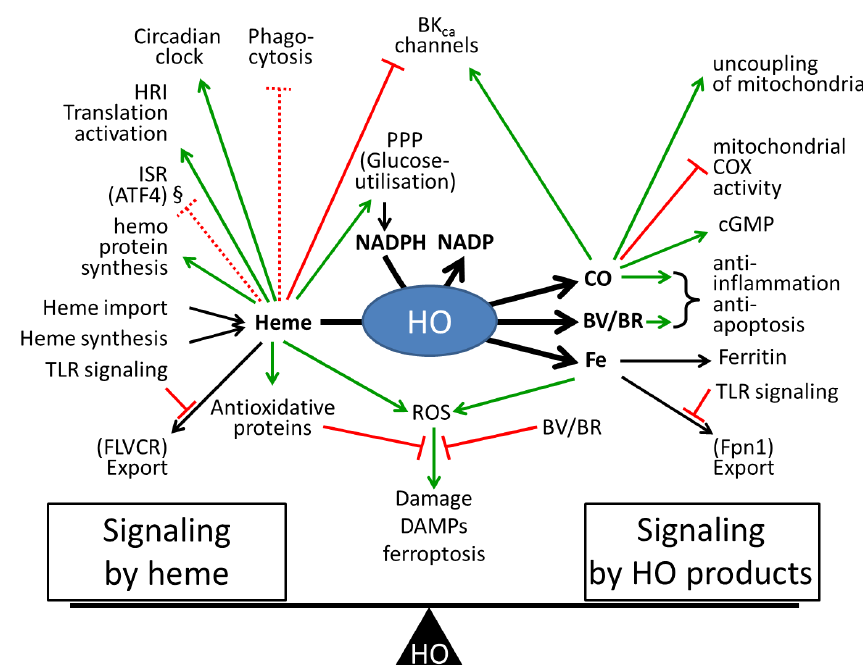
Figure 2. Role of HO as master regulator of cell physiology. Highly active HO shifts the balance from heme mediated signaling towards HO product mediated signaling. Low activity results in an increased heme mediated signaling. Black arrows indicate direct processes associated with HO activity. Green arrows indicate elicited e ff ects; red blocks indicate inhibitory actions of the indicated compounds. Interactions occurring in specialized cells, such as erythroid cells, or macrophages, are indicated by dotted lines. §, integrated stress response (ISR) pathway is activated via ATF4 by heme deficiency, indicating that physiological heme levels repress ATF4 activation. Abbreviations: ATF4, Activating transcription factor 4; BK Ca , conductance Ca 2 + -activated K + channels; BV / BR, biliverdin / bilirubin; cGMP, cyclic guanosine monophosphate, CO, carbon monoxide; COX, cytochrome c oxidase; DAMPs, danger associated molecular pattern; FLVCR, Feline leukemia virus subgroup C receptor; FPN1, ferroportin 1; PPP, pentose phosphates pathway; ROS, reactive oxygen species; TLR, Toll-like receptors.